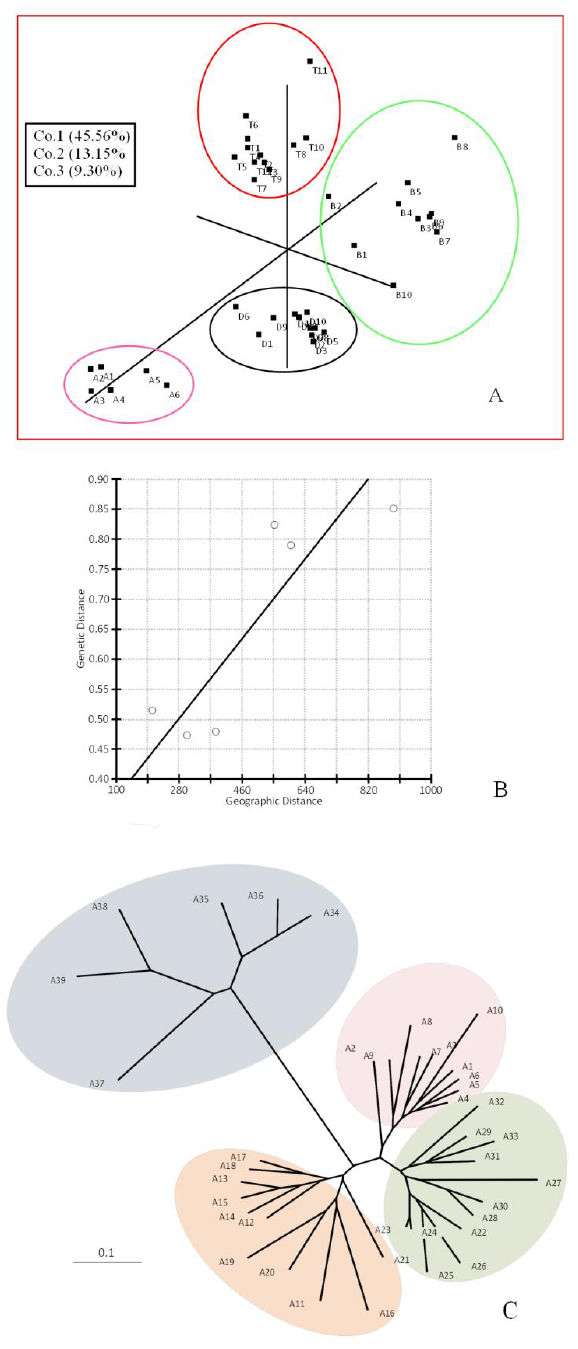
Figure 1. PCO Analysis, Correlation between genetic and geographic distances, and Midpoint rooted neighbor-joining tree. ( A ) Three-dimensional PCO analysis of ISSR data; ( B ) Correlation between genetic and geographic distances plotted with Z = 2119.05, r = 0.867 as calculated by the Mantel test; ( C ) Midpoint rooted neighbor-joining tree of samples from four populations of P. atlantica Desf. generated with ISSR data. Individuals from A1–A10 belong to the Batna population, A11–A21 to the Djelfa population, A22–A33 to the Tiaret population, and A34–A39 to the Bechar